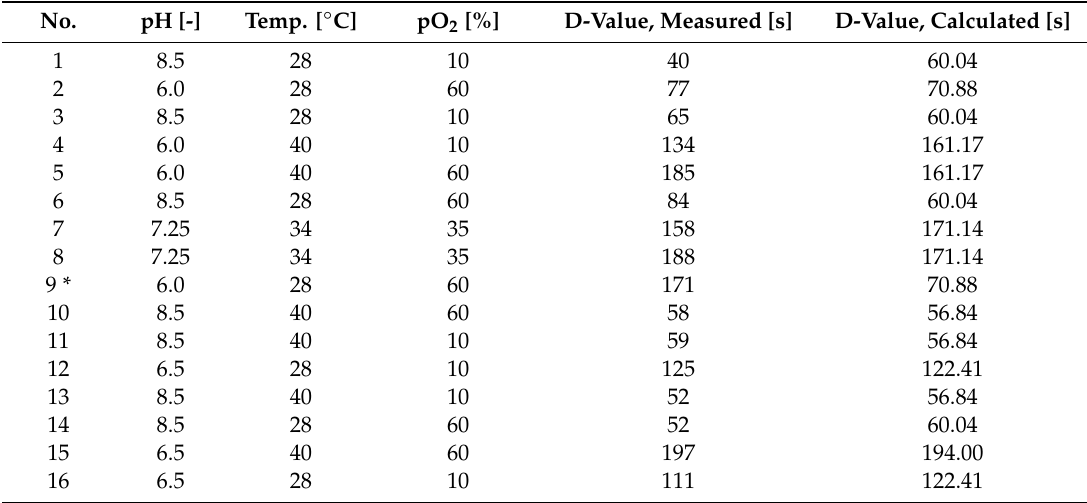
Table 1. Experimental plan and results of the full factorial Design of Experiments (DoE) to investigate the influence of sporulation conditions (pH, temperature and oxygen saturation) on the resistance (D-value) of the spores of B. atrophaeus in the